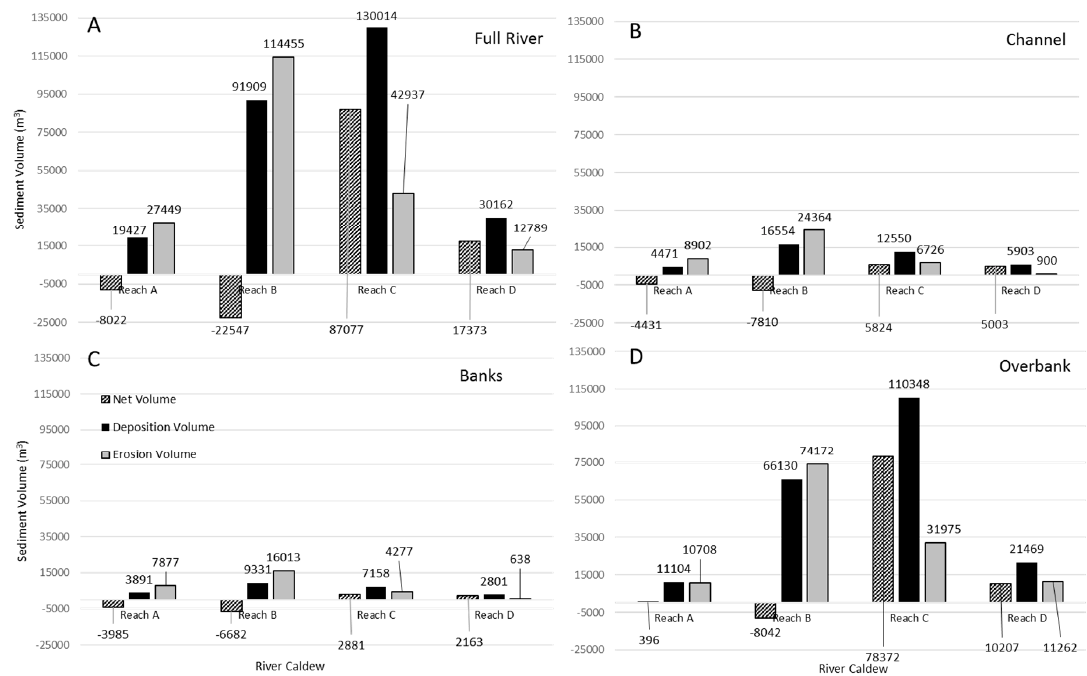
Figure 7. Gross overall in-channel, bank margin and overbank sediment volume change, erosion and deposition, along the River Caldew split by study reaches: ( A ) all river, ( B ) in-channel, ( C ), bank margin and ( D ) overbank.